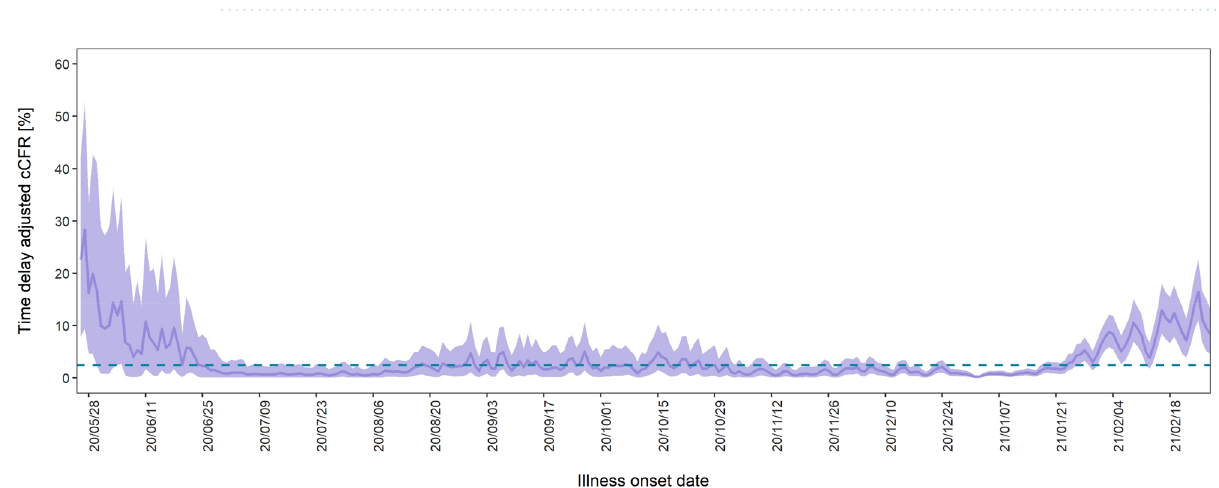
Figure 3. Temporal variation of time-delay adjusted case fatality risks (CFR) with unbiased CFR from 25th May 2020 to 28th February 2021 in Tokyo, Japan. The mean values of time-delay adjusted daily case fatality risks (CFR) from 25th May 2020 to 28th February 2021 are shown with a purple line. The shade region represents the 95% confidence intervals. The blue dot line shows the unbiased case fatality risk as 2.42% (95% credible interval: 2.41–2.43). If the time-delay adjusted daily CFR gets higher or lower, it is caused by random noises or other variables which have causal relationships. The unbiased case fatality risk plays a key role as a reference of the daily